Question: What type of chart is this?
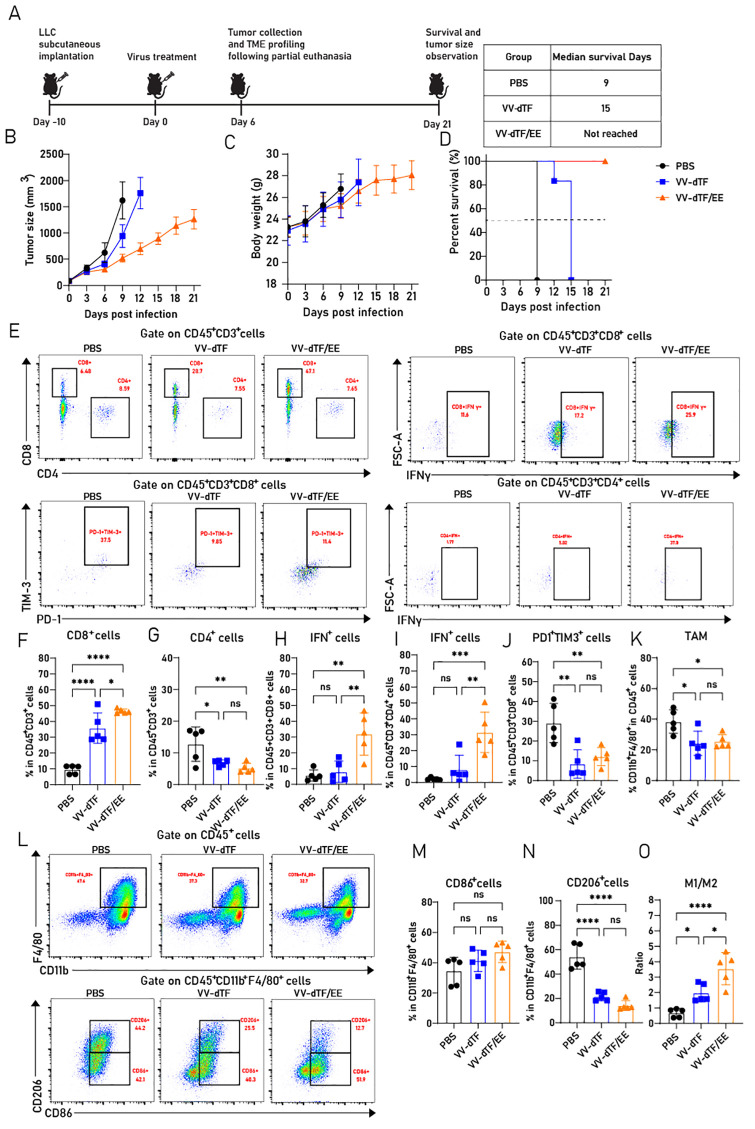
Answer: scatter